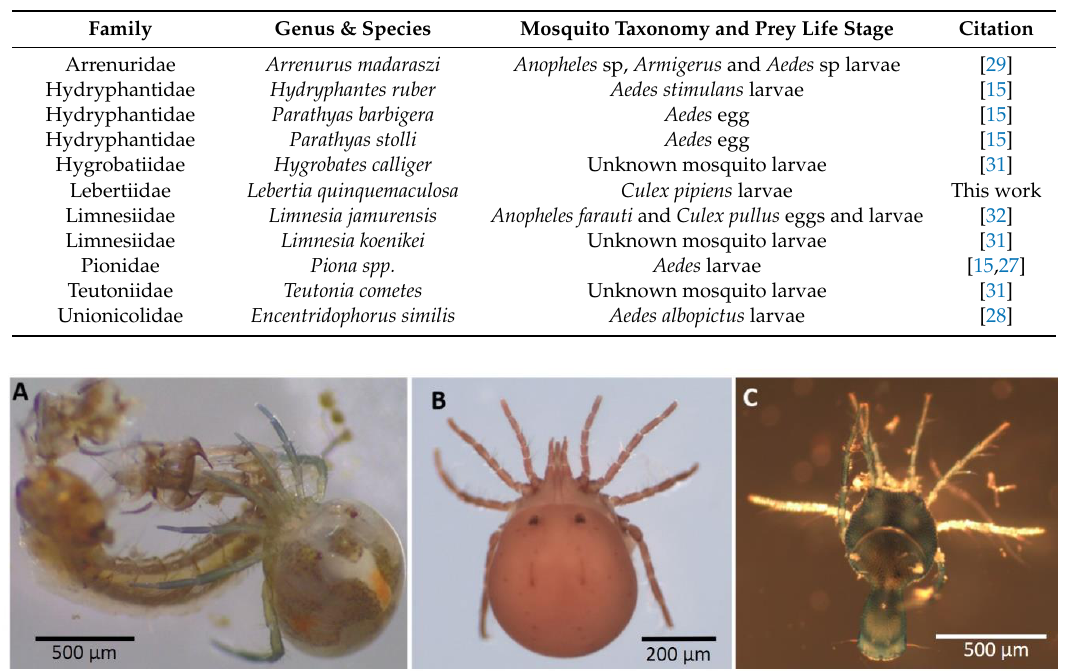
Table 2. The biodiversity of water mite predators of mosquitoes.